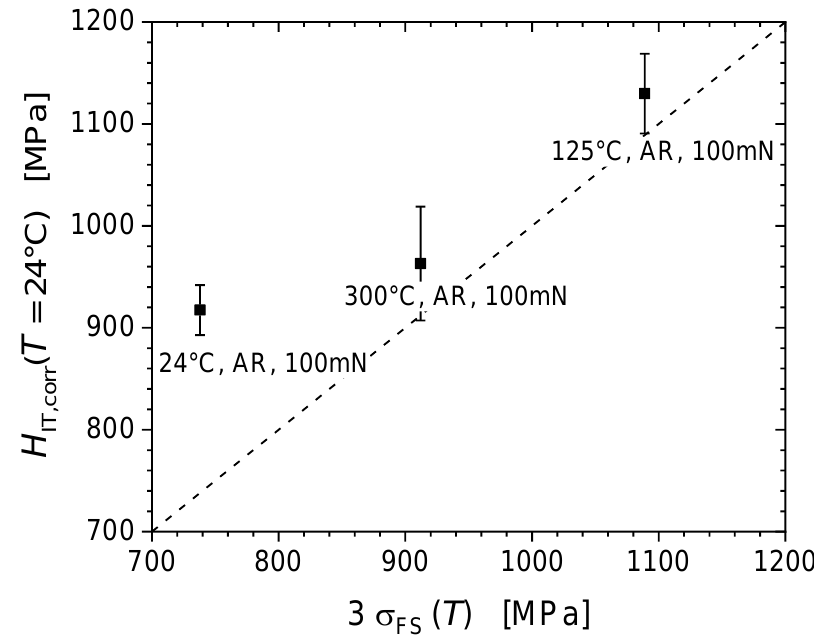
Figure 10. Hardness vs. tensile strength correlation after EMC.